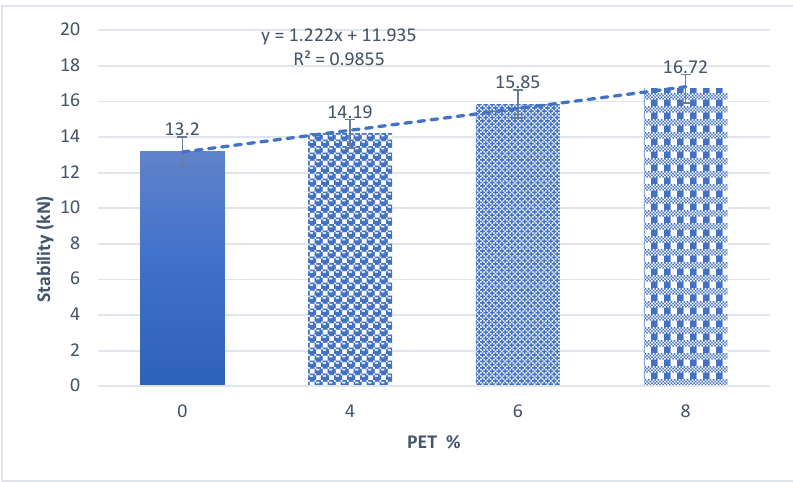
Figure 4. Marshall stability of the PET-modified AC asphalt mixtures.